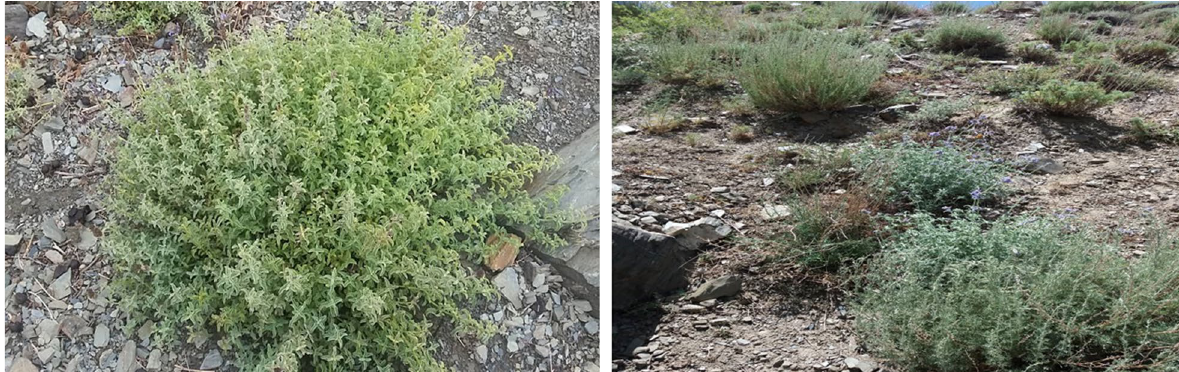
Fig. 3 Scatter plot for 20 populations of Nepeta binaludensis and three clusters for the first two principal